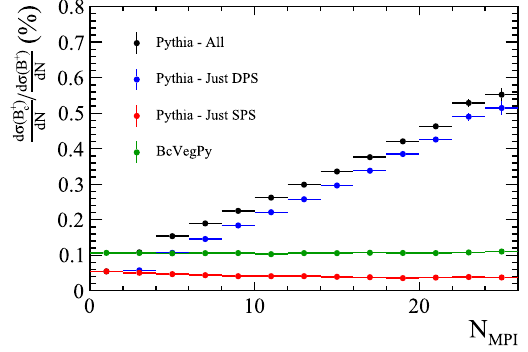
Fig. 10 Ratio of differential cross-sections of B + c and B + mesons as a function of (top left) the number of parton–parton interactions in a collision and (top right) the number of charged particles within the